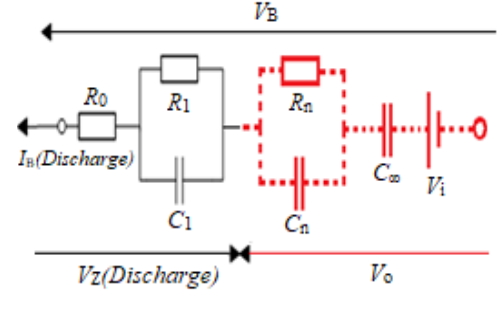
Figure 3. Proposed equivalent model.